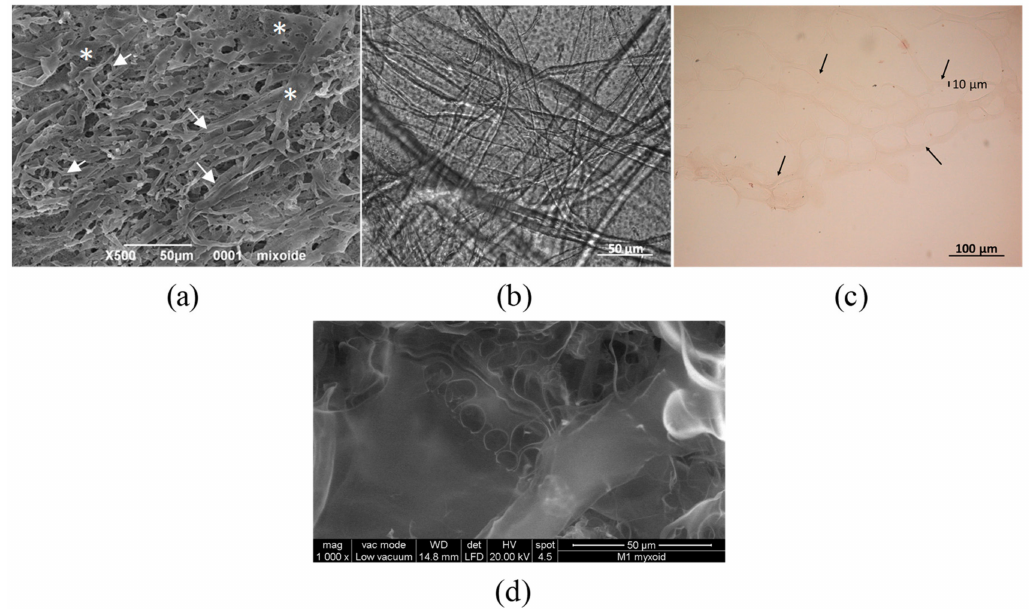
Figure 3. SEM images of the dried sca ff old (panel a , left) and of the sca ff old after hydration with DMEM medium for 2 h of incubation at 37 ◦ C for 7 days with medium (panel b ), inclusion in agar and staining with H&E (panel c , right). Panel d , ESEM image of the sca ff old at 1000 × magnification.